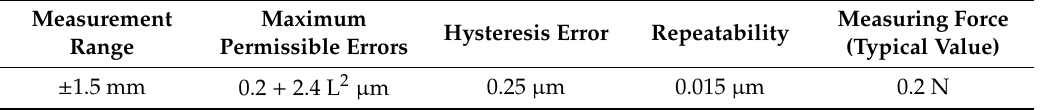
Table 1. The key parameters of